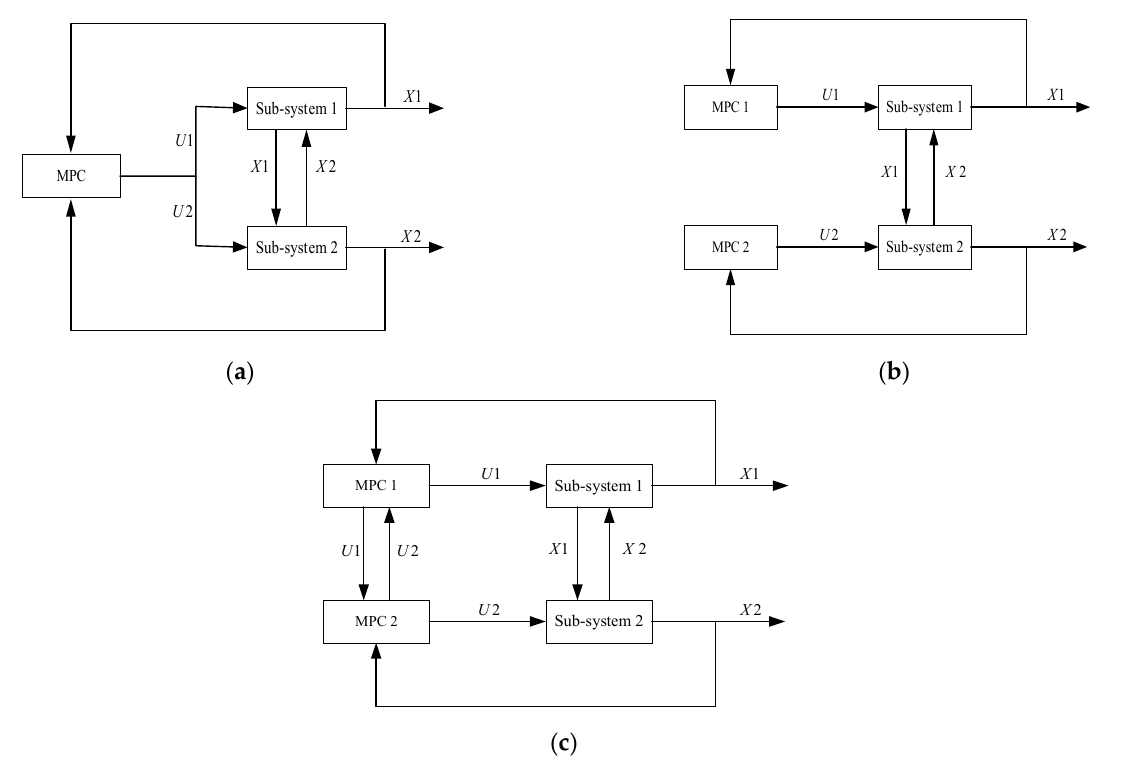
ized and distributed MPC has an independent model predictor, which reduces the dimen- sionality of the system. It also reduces the amount of calculation for the online optimiza- tion of each sub-controller and increases the reliability of the system. The difference be- tween the distributed and decentralized MPC is that there is no information interaction between the sub-controllers of the decentralized MPC. As a result, it cannot control the problem of the multi-agent system with coupling between the sub-systems.